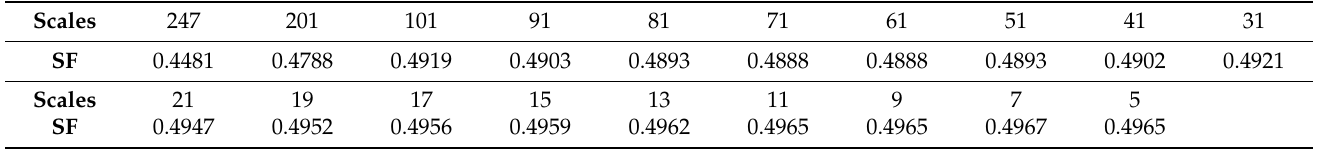
Figure 4. The sparse factor curve.